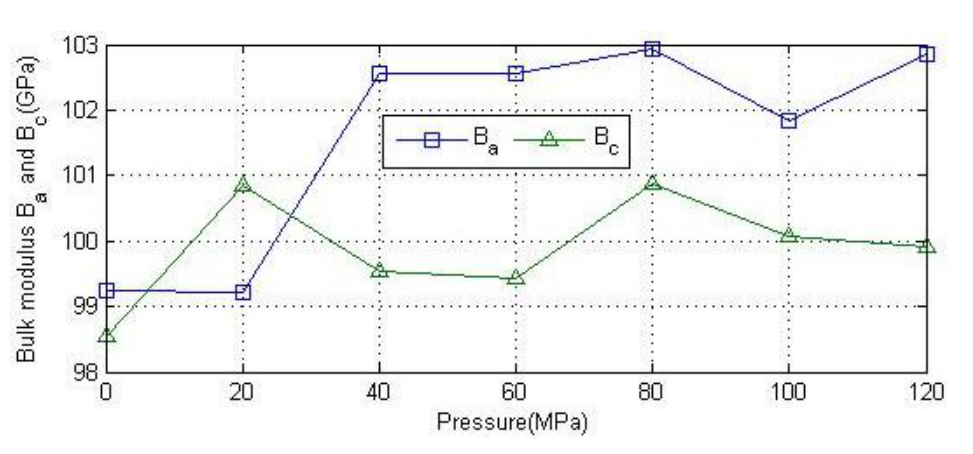
Figure 10. The modulus of anhydrite crystals at pressures of 0 MPa, 60 MPa and 120 MPa.